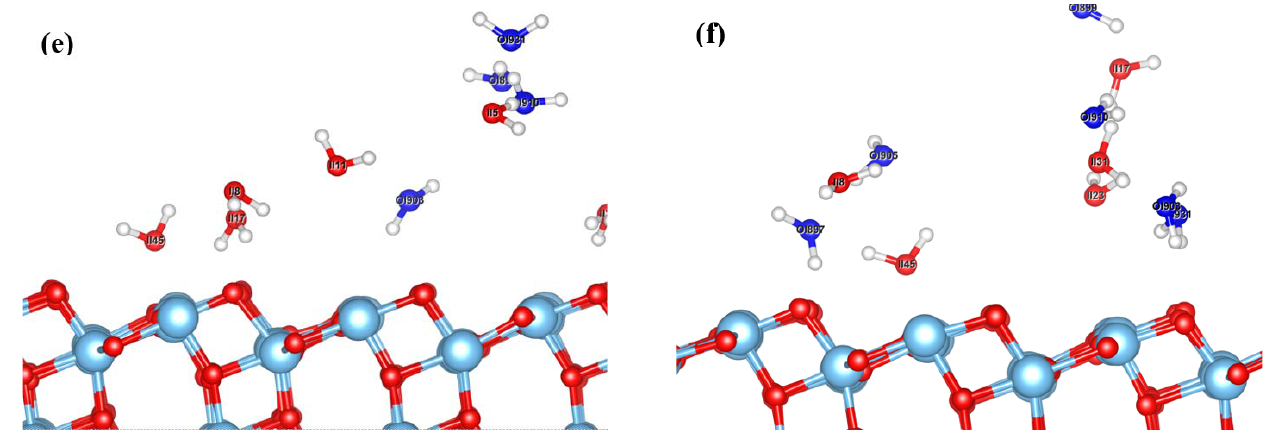
Figure 6. Snapshots of TiO 2 /water interfacial structures of anatase (101) at ( a ) 0, ( b ) 50, ( c ) 100, ( d ) 150, ( e ) 200 and ( f ) 300 ps, respectively. Titanium atoms are shown in light blue, TiO 2 oxygen atoms in red, water hydrogen in white, and water oxygen in red for IHL, and dark blue for IHL.